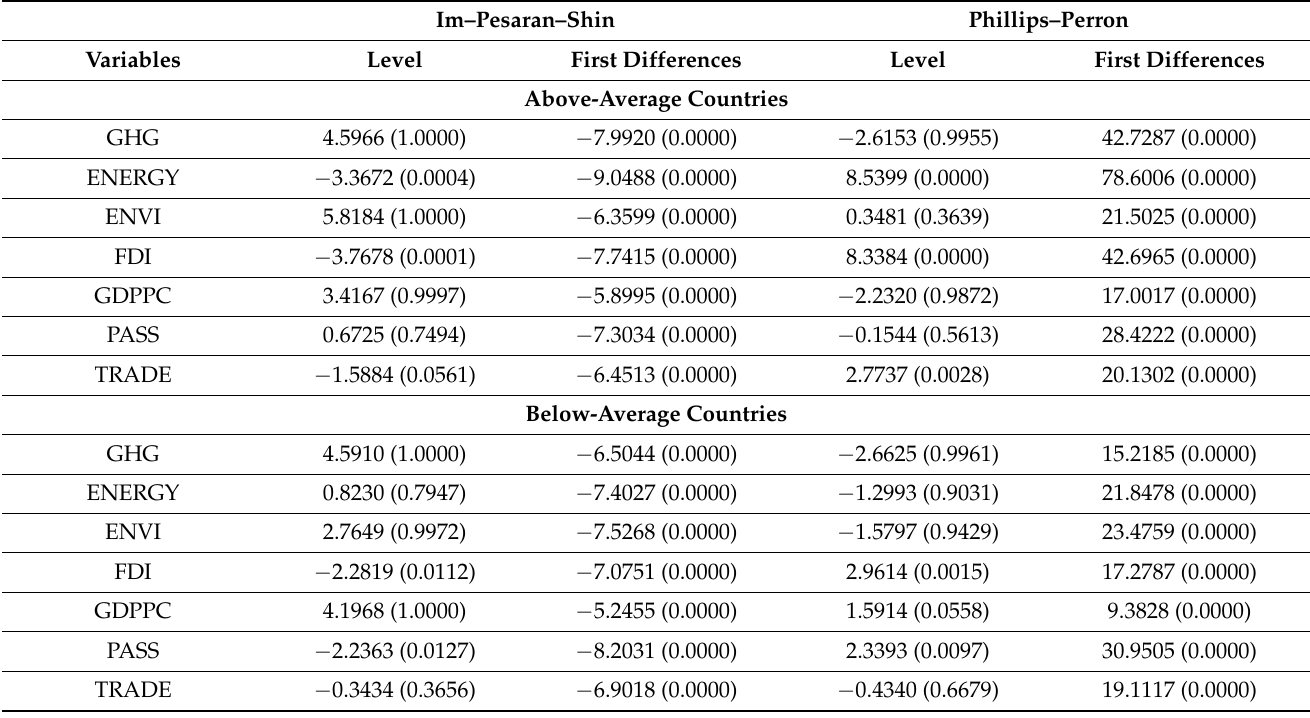
Table 4. Unit root test results. Source: